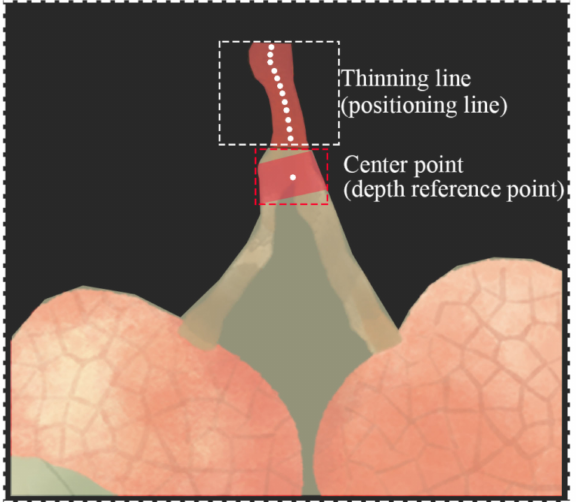
Figure 9. “Point + Line” location